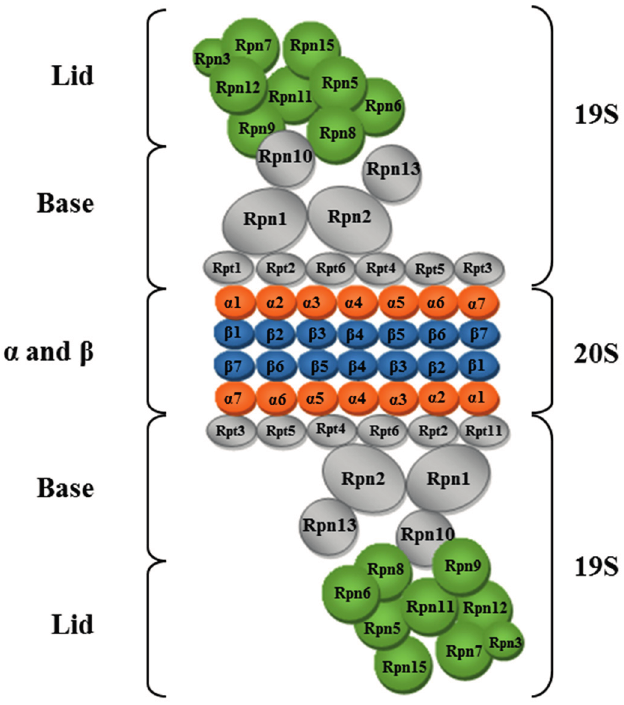
Figure 4. Scheme of the 26S proteasome. Proteins that make up the base and lid of the 19S regulatory subunit are shown. The cylindrical portion of the 20S catalytic subunit is shown in an open conformation, showing the arrangement of α and β proteins identified in orange and blue, respectively (Adapted from